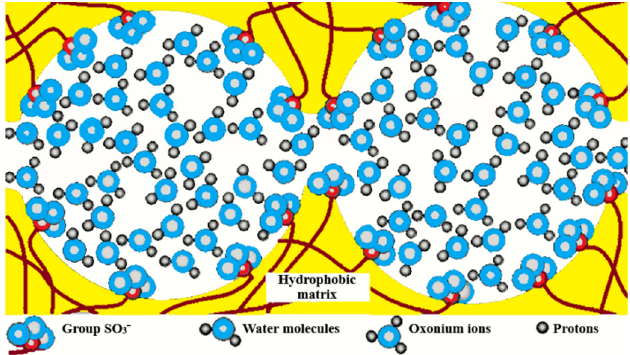
Figure 2. Schematic representation of Gierke model. Reprinted with permission from Ref. [7]. Copyright © 2022 Pleiades Publishing, Ltd.